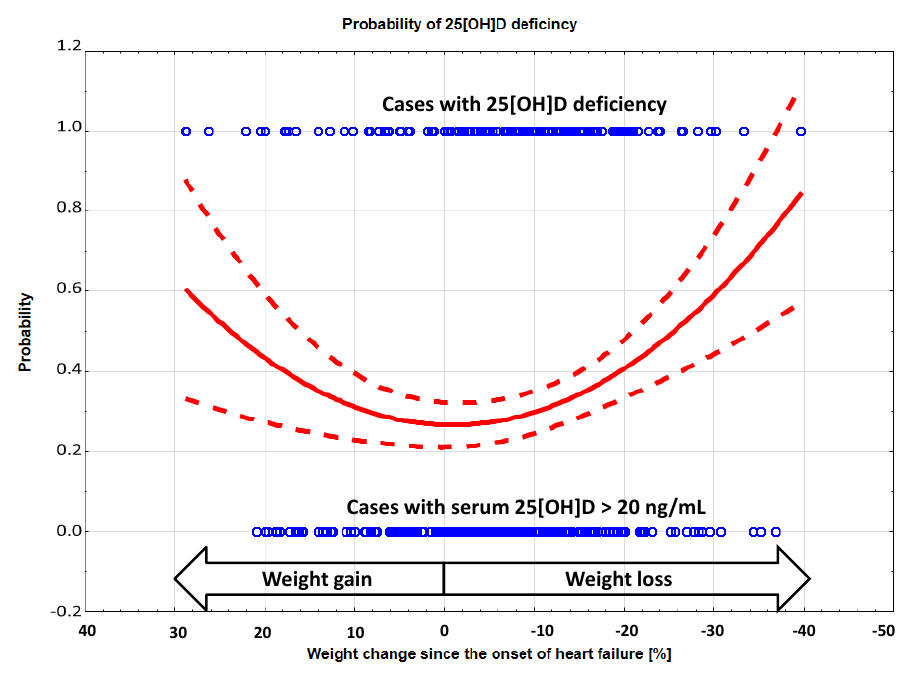
Figure 3. Probability and 95% confidence intervals of 25[OH]D deficiency across spectrum of